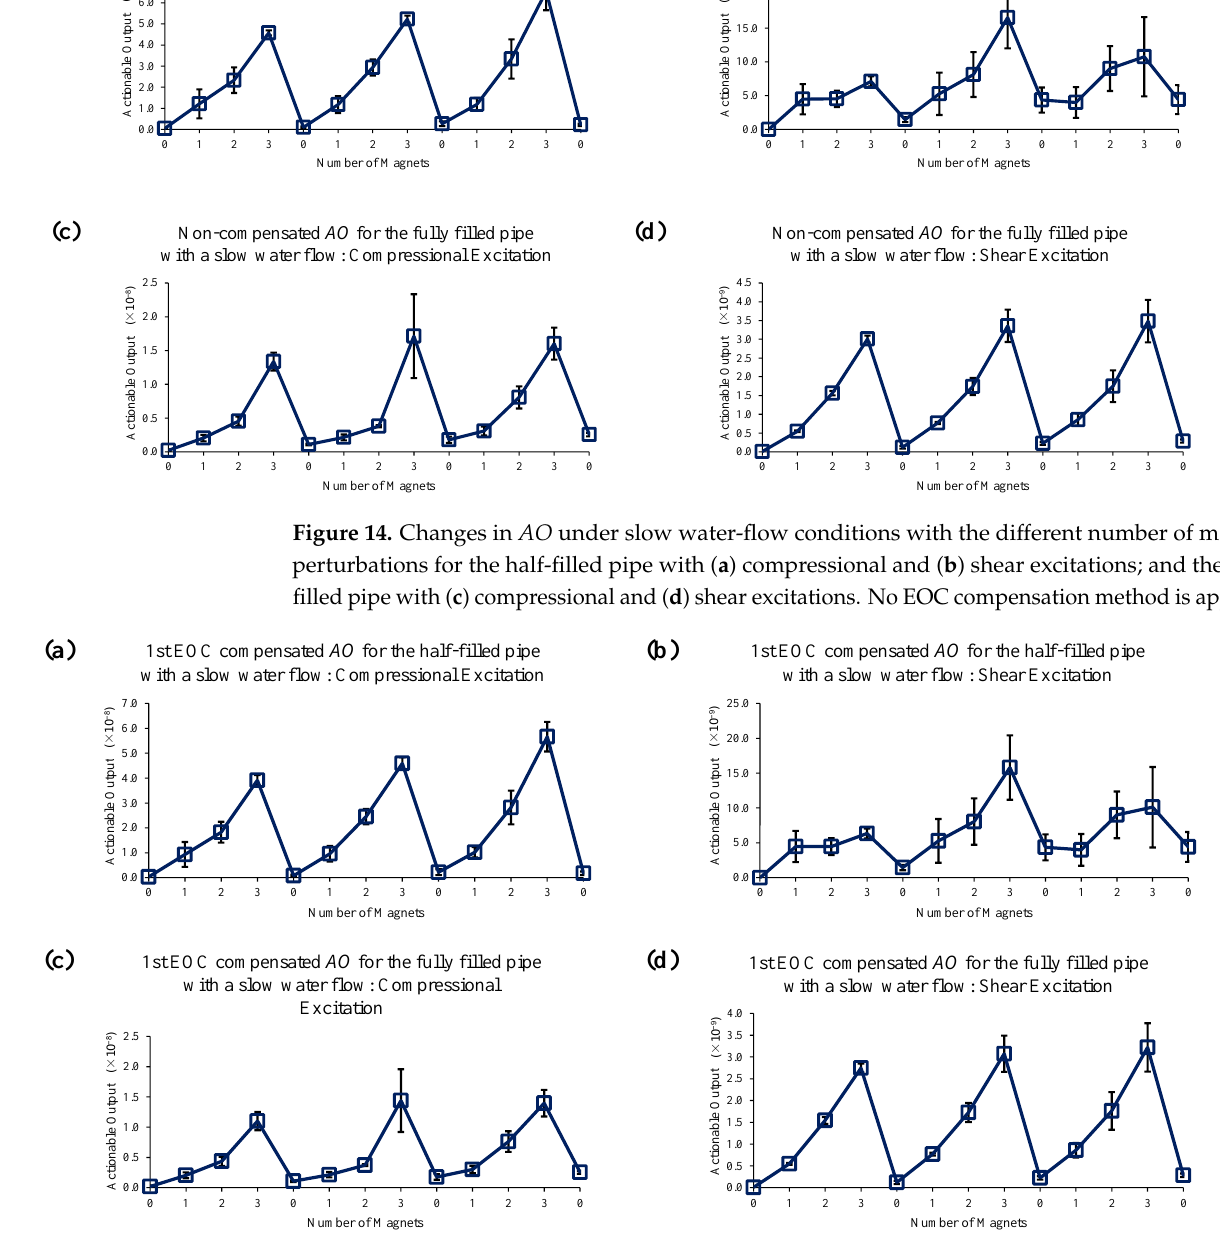
Figure 15. Changes in AO under slow water-flow conditions with the different number of magnet perturbations for the half-filled pipe with ( a ) compressional and ( b ) shear excitations; and the fully filled pipe with ( c ) compressional and ( d ) shear excitations. Only the 1st EOC compensation method is applied.